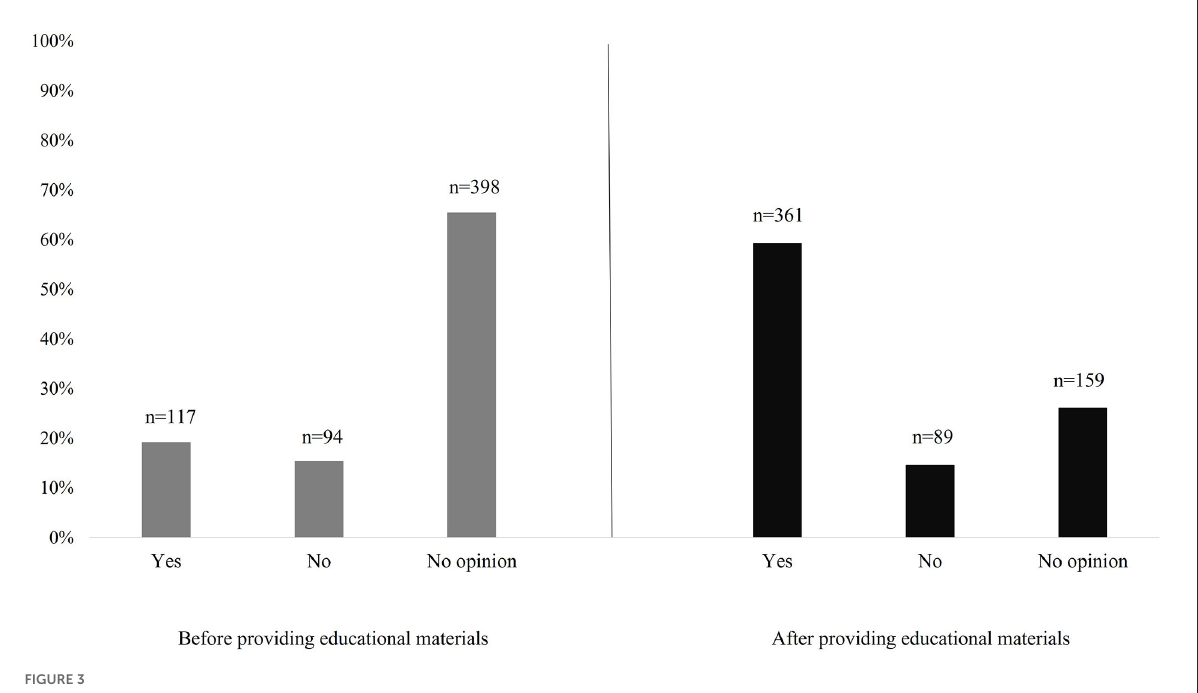
FIGURE3 Irradiated food purchase declaration before and after providing educational materials.